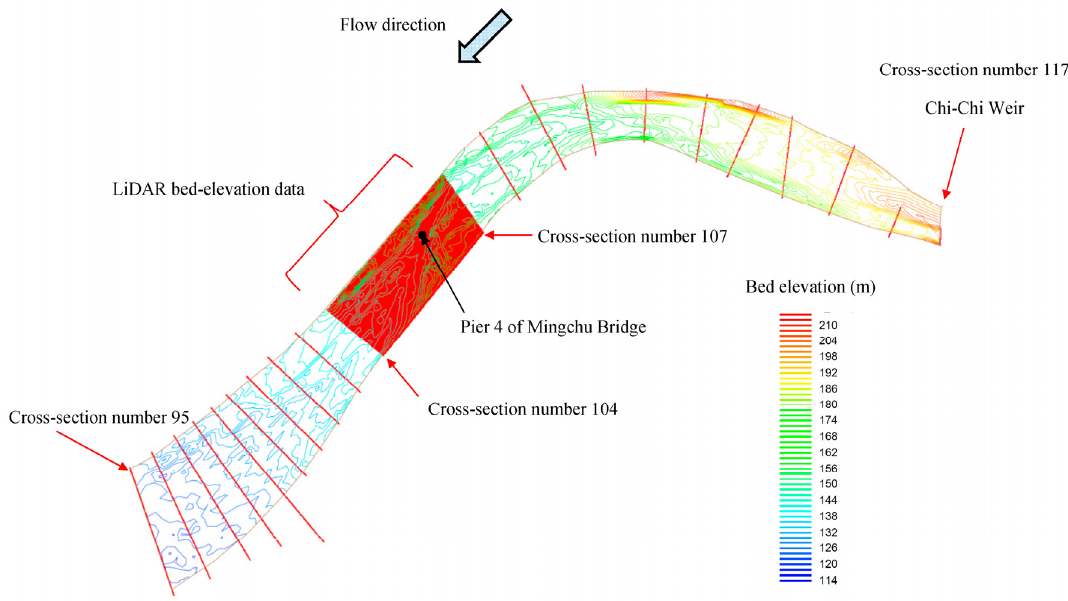
Figure 11. Simulated domain and the corresponding bed elevation.